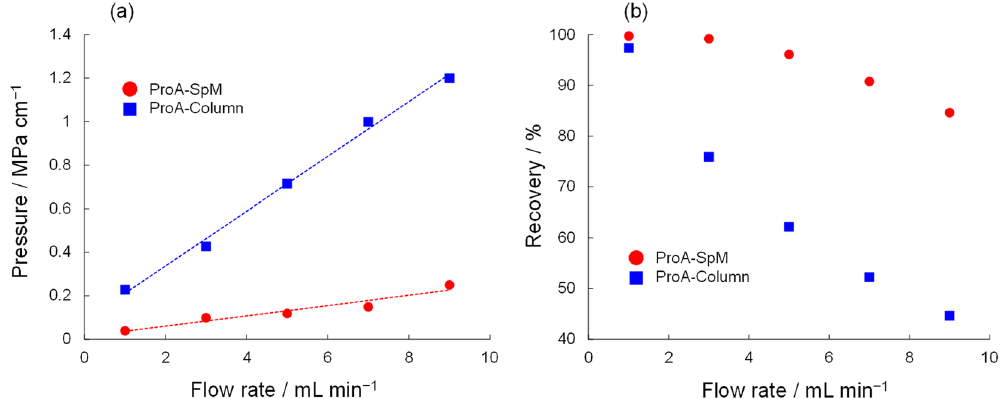
Figure 4. Back pressure and recovery of IgG on the ProA-Column and ProA-SpM. ( a ) Comparison of back pressure on LC eluted by 50 mM phosphate buffer with 150 mM NaCl as a mobile phase using the ProA-Column or ProA-SpM. ( b ) Comparison of the recovery for IgG with the ProA-Column or ProA-SpM, total amount was estimated by sum of the peak area among the flow though peak and